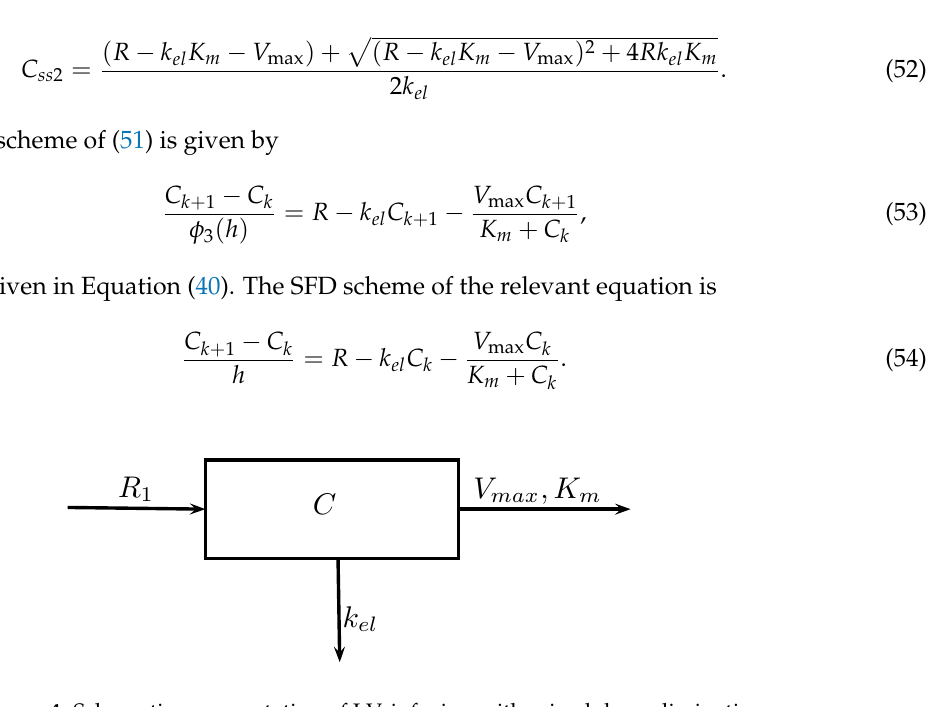
Figure 4. Schematic representation of I.V. infusion with mixed drug